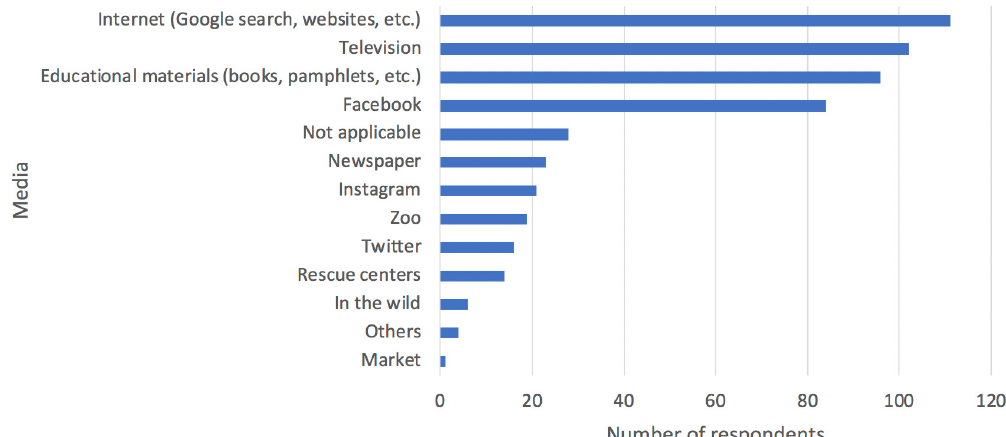
Figure 1. Media where the respondents saw a